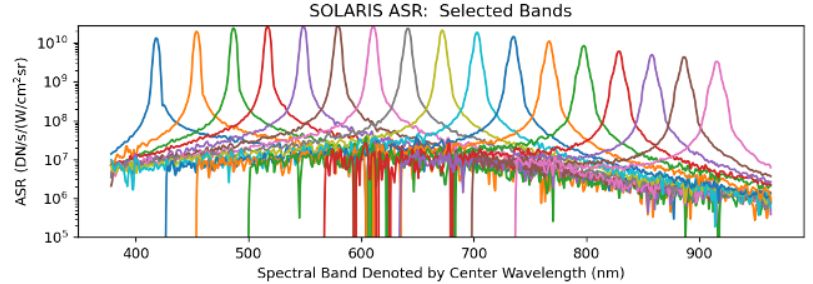
Figure 13. ASRs for representative SOLARIS spectral bands (detectors) after